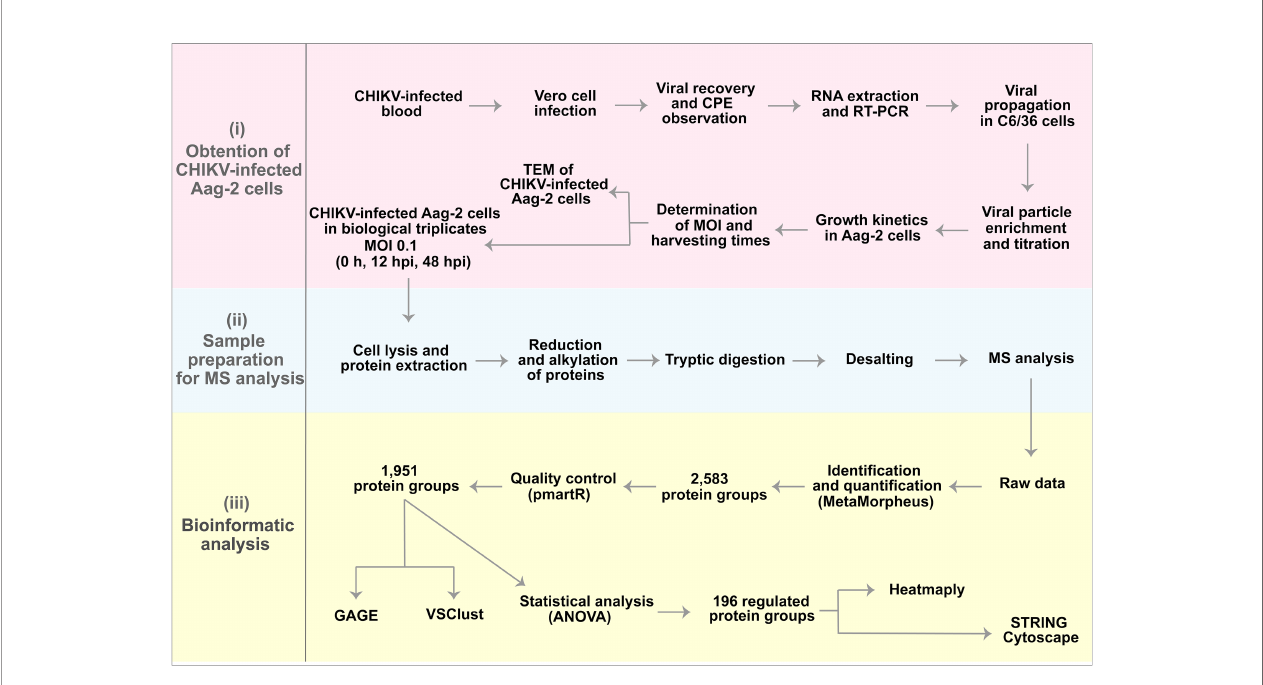
FIGURE 1 | Experimental design and preliminary results. (i) Obtention of chikungunya virus (CHIKV)-infected Aag-2 cells, which consisted of the determination of multiplicity of infection (MOI) (1), harvesting times (0, 12, and 48 hpi), and microscopy analysis. (ii) Sample preparation for mass spectrometry (MS) analysis. (iii) Bioinformatics analysis that resulted in 196 proteins statistically signi fi cant as upregulated or downregulated.